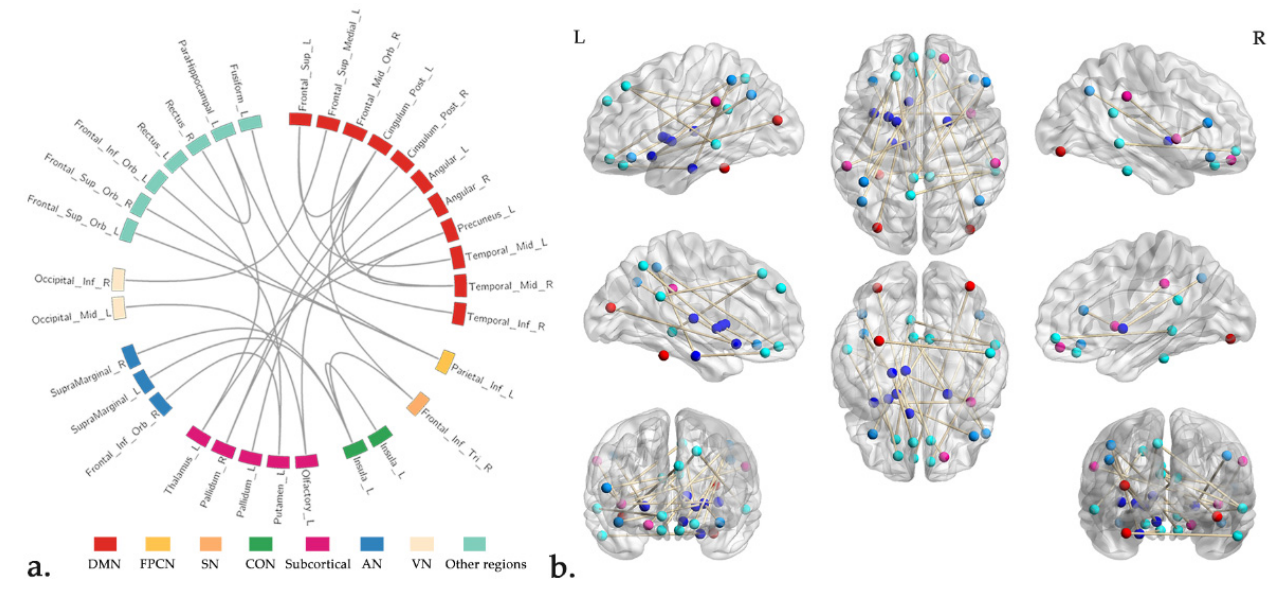
Figure 1. The selected FC features for discriminating the SCC from BC group. Part ( a ) showed the distribution of FC features in different brain network regions, and part ( b ) showed the spatial distribution of the FC features across the brain. Abbreviations: DMN, default mode network; FPCN, frontal-parietal control network; SN, salience network; CON, cingular-opercular network; AN, auditory network; VN, visual network; L, left; R, right.